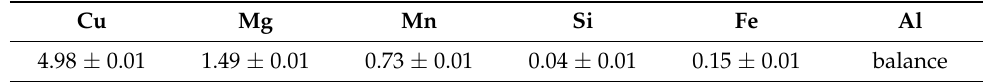
Table 1. Chemical composition of the studied alloy (wt.%).